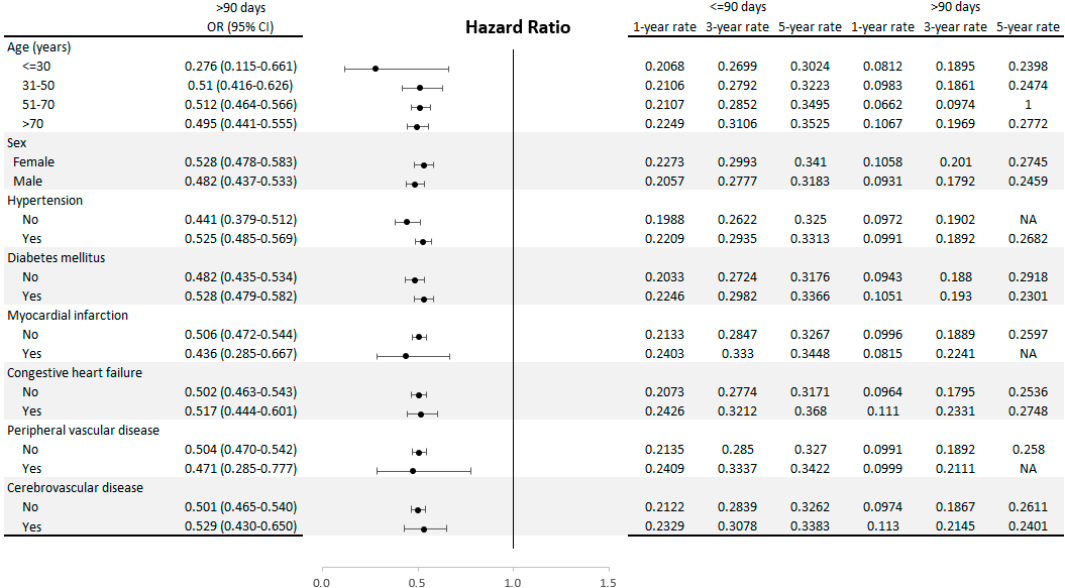
Figure 5. Subgroup hazard ratio for short survival. AVF (arteriovenous fistula) creation [<90 days as